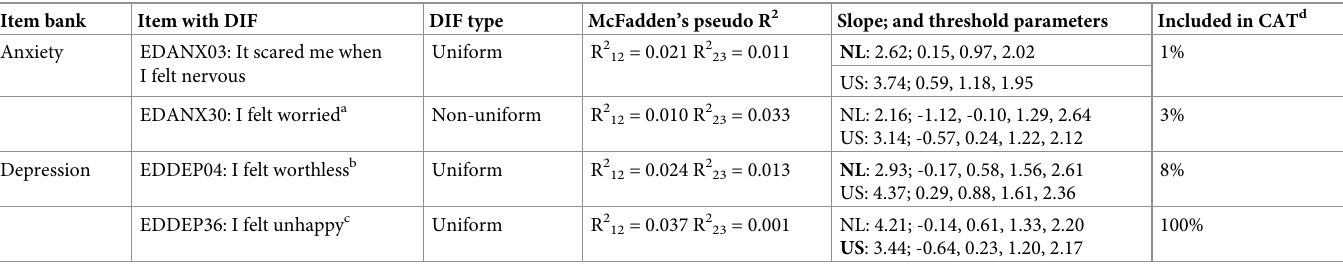
Table 2. McFadden’s pseudo R 2 and IRT parameters for items displaying DIF.